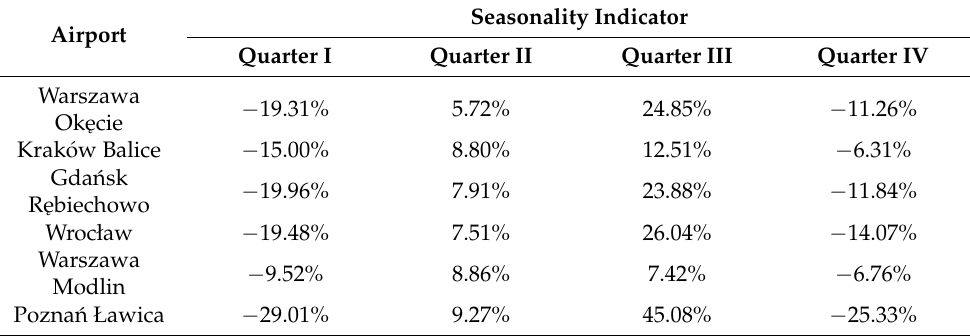
Table 3. Seasonality indicators.